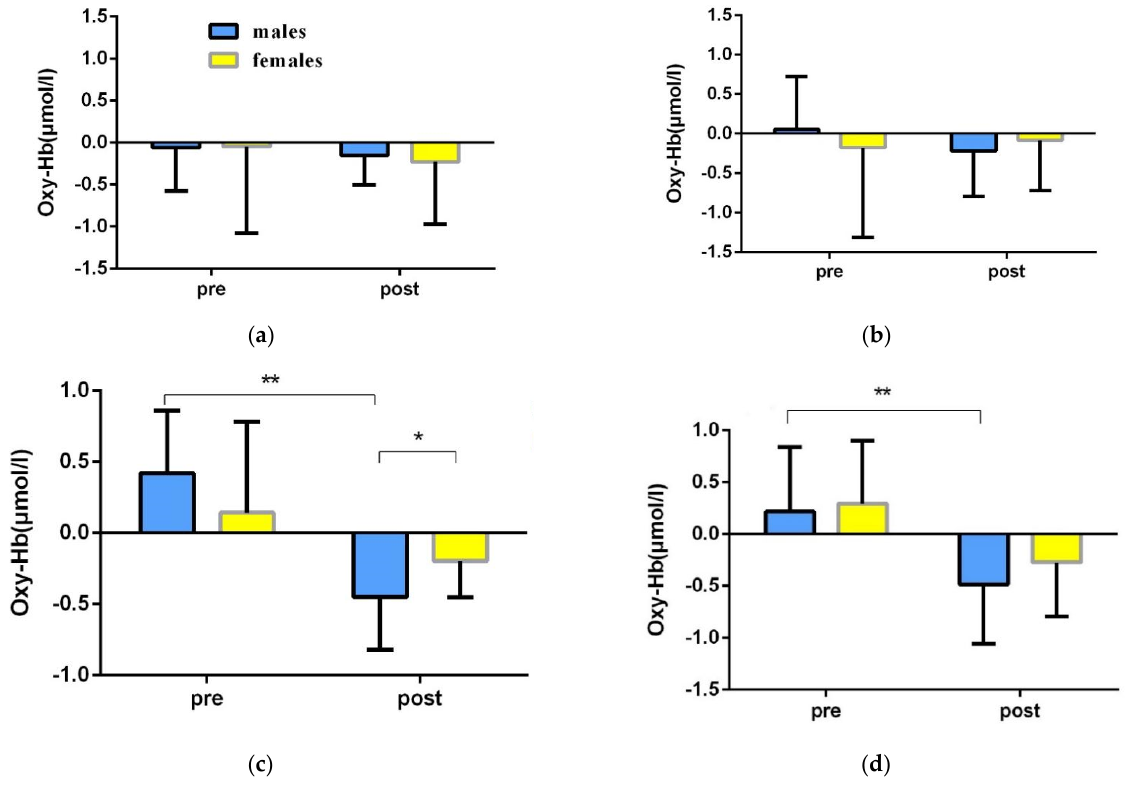
Figure 7. Changes of fNIRS results before and after exercise intervention in experimental group and control group. (Changes in different brain regions before and after directed motor intervention ( a ) L ‐ VLPFC; ( b ) R ‐ VLPFC; ( c ) L ‐ DLPFC; ( d ) R ‐ DLPFC; blue represents the experimental group, yellow represents the control group. * 0.01 < p < 0.05; ** p < 0.01)